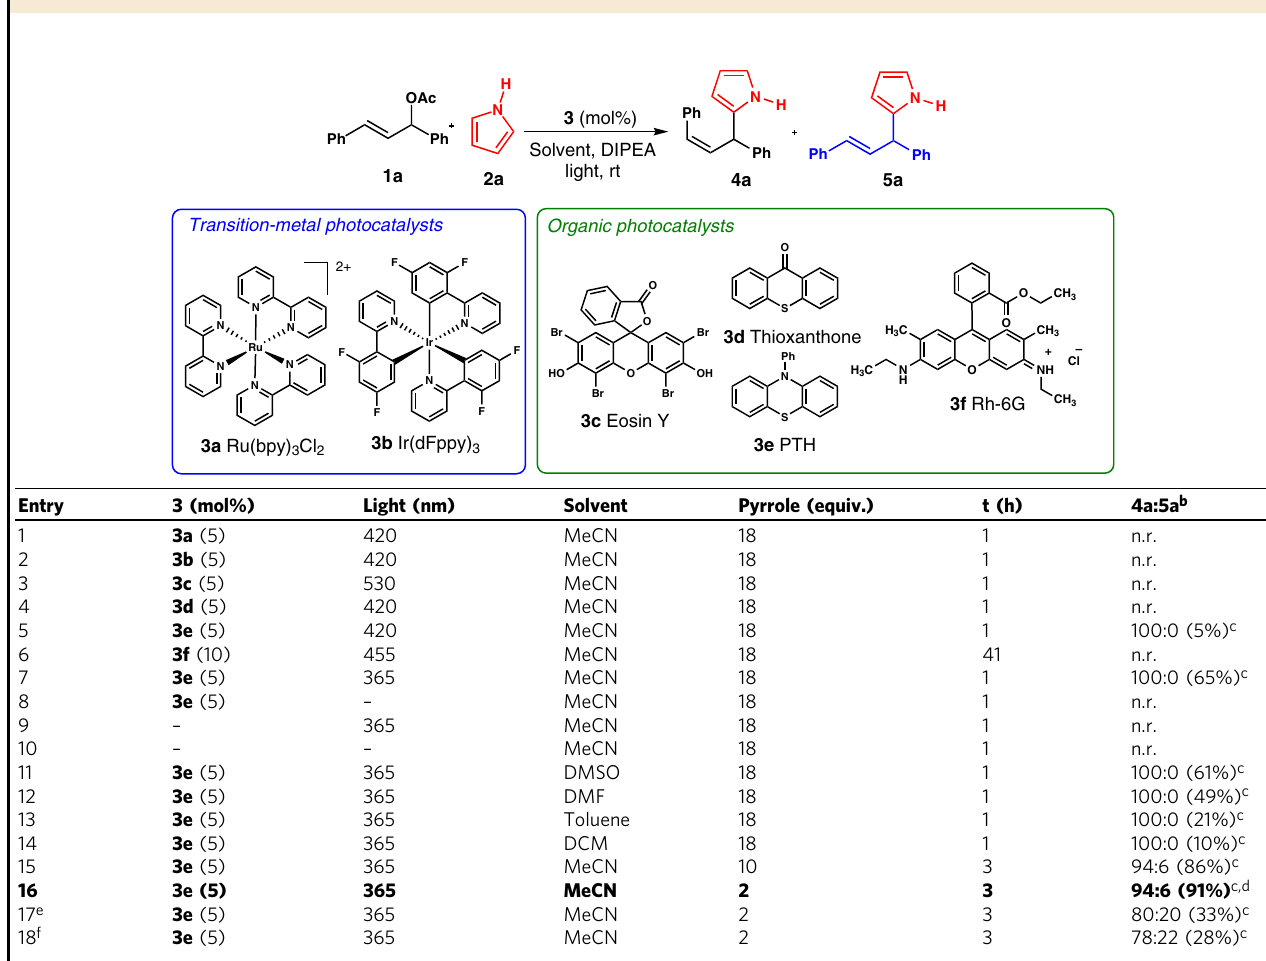
Table 1 Optimization of the photocatalytic allylation reaction a